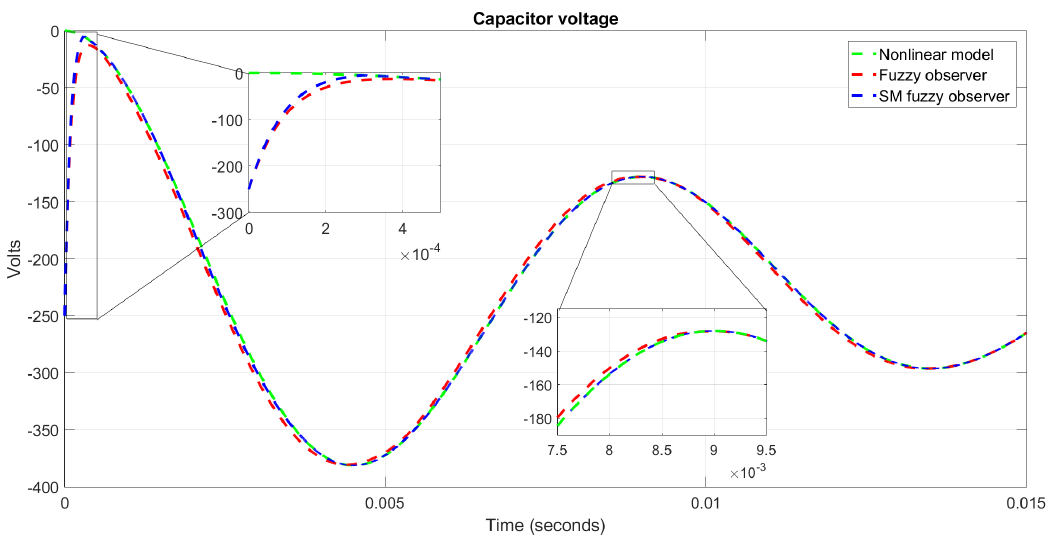
Figure 13. Voltage transient in v C with different conditions, v C ( 0 ) = 0 V and ˙ˆ v C ( 0 ) = − 250